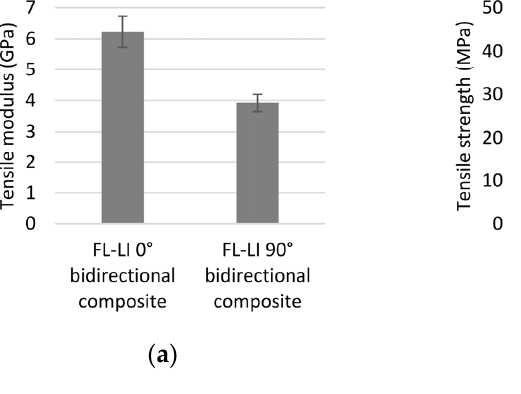
Figure 8. ( a ) Tensile modulus of FL-LI composites; ( b ) tensile strength of FL-LI composites; ( c ) elon- gation of FL-LI composites.